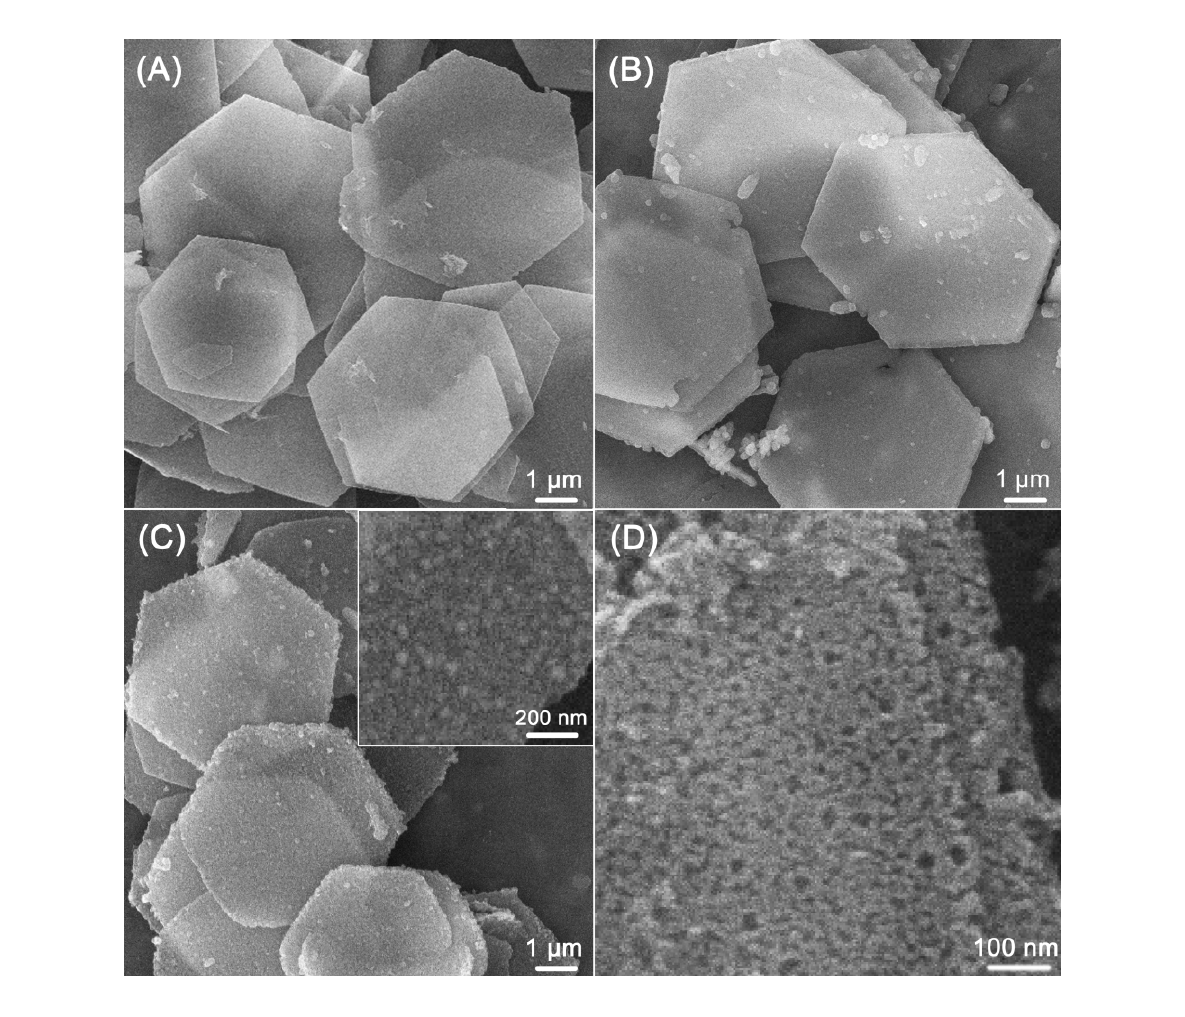
Figure 2: SEM images of: (A) pure CoAl LDH; (B) LDH@PDA-2.5 composite; (C) NPLs-2.5-800, the inset shows a high-magnification SEM image; (D) NPLs-S prepared by removal of Co nanoparticles embedded in NPLs-2.5-800 with HCl etching.